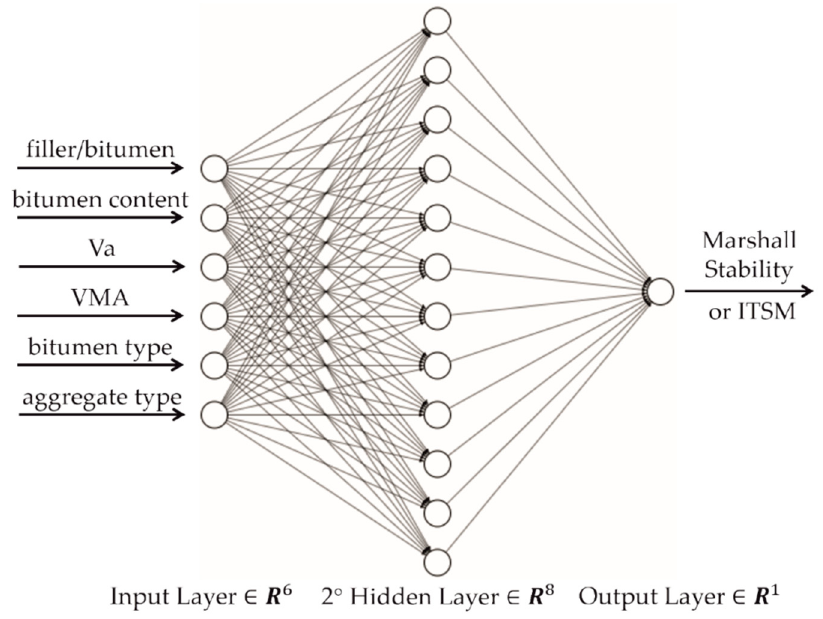
Figure 7. ANN final architecture to predict the Marshall quotient.